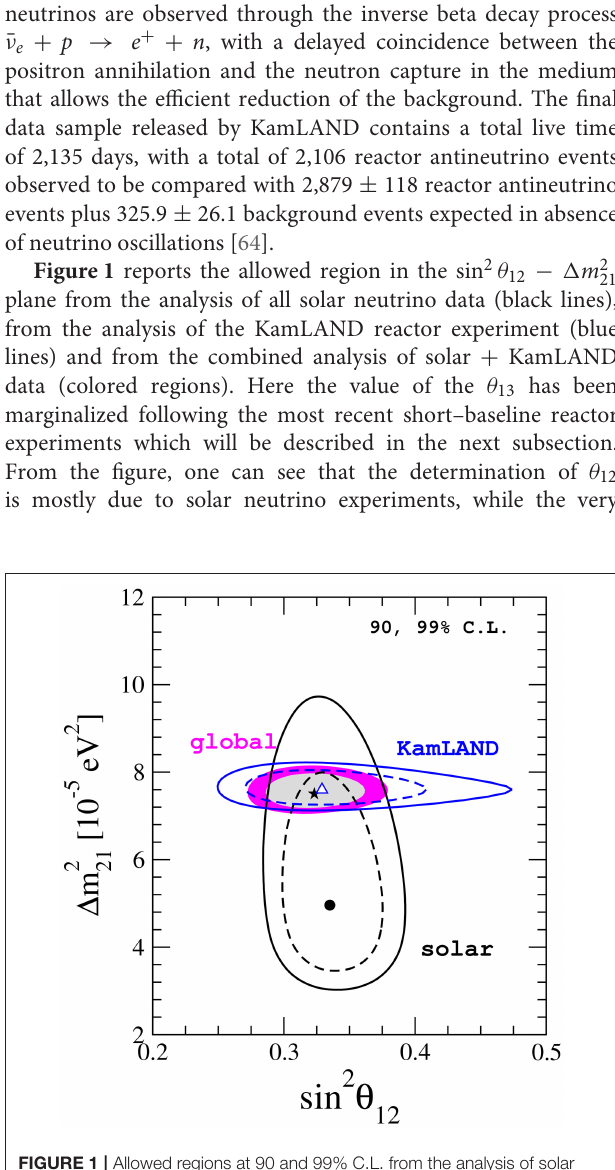
FIGURE 1 | Allowed regions at 90 and 99% C.L. from the analysis of solar data (black lines), KamLAND (blue lines) and the global fit (colored regions). θ 13 has been marginalized according to the latest reactor measurements [39]. Triangle and circle respectively denote KamLAND and solar best fit. The global best fit is denoted by a